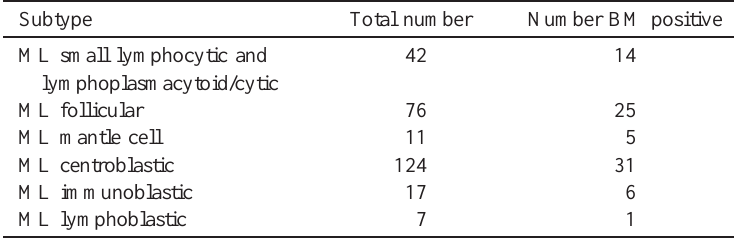
Table 2 Histological subtypes of B cell non Hodgkin’s lymphoma (excluding CLL) at